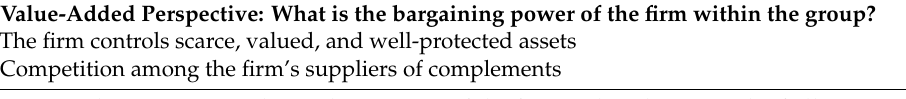
Table 1. Relevant factors shaping an EV charging firm’s claim on value [33].